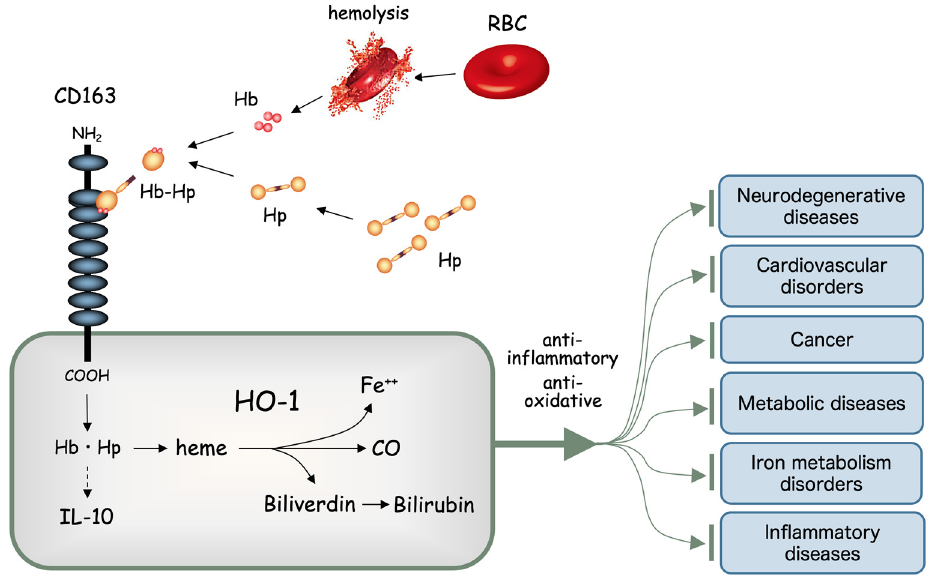
Figure 1. Heme oxygenase (HO)-1 and the heme degradation pathway. Free hemoglobin (Hb) quickly binds with haptoglobin (Hp) to form a molecular complex (Hb-Hp). Hb-Hp is rapidly incorporated through the scavenger receptor, now known as CD163, expressed on the cell surface of tissue macrophages such as hepatic Kupffer cells. Heme derived from Hb is degraded by HO-1 into free iron (Fe ++ ), carbon monoxide (CO) and biliverdin. Biliverdin is further degraded into bilirubin by biliverdin reductase. All these heme degradation products are known to exert potent anti-inflammatory and anti-oxidative stress functions, which in turn play significant roles in preventing various chronic diseases.